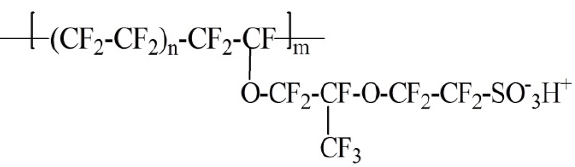
Figure 1. Chemical structure of Nafion in the sulfonic acid